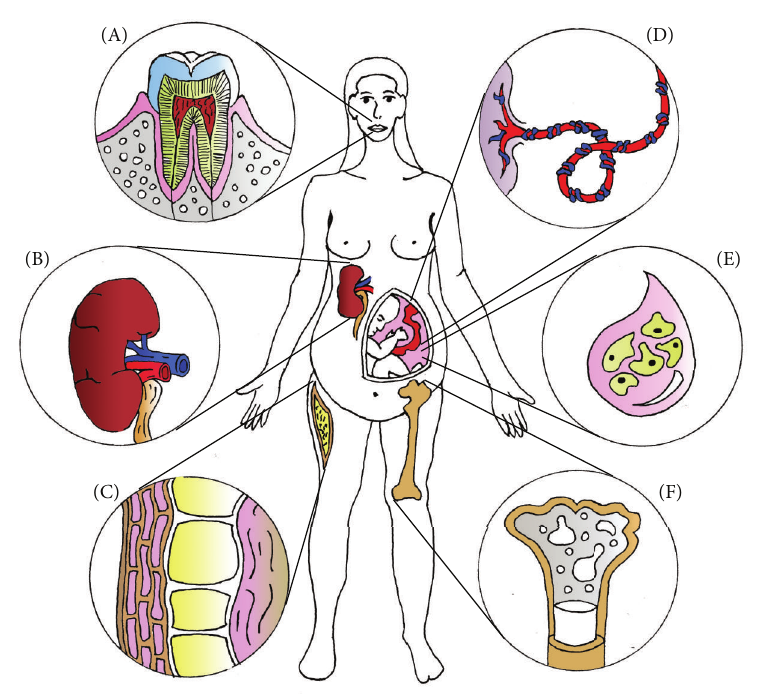
Figure 1: Sources of MSC used in experimental models of renal injury. Preclinical studies have shown that MSC used to treat renal diseases can be isolated from the following tissues: (A) tooth pulp, (B) kidney, (C) adipose tissue, (D) umbilical cord, (E) amniotic fluid, and (F) bone